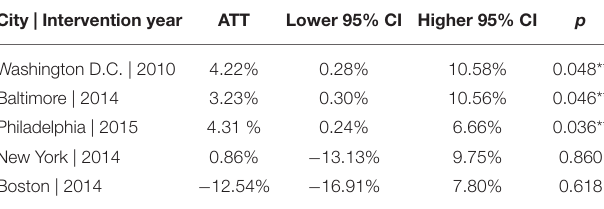
TABLE 3 | Treatment effects on percentage of population insured in treated